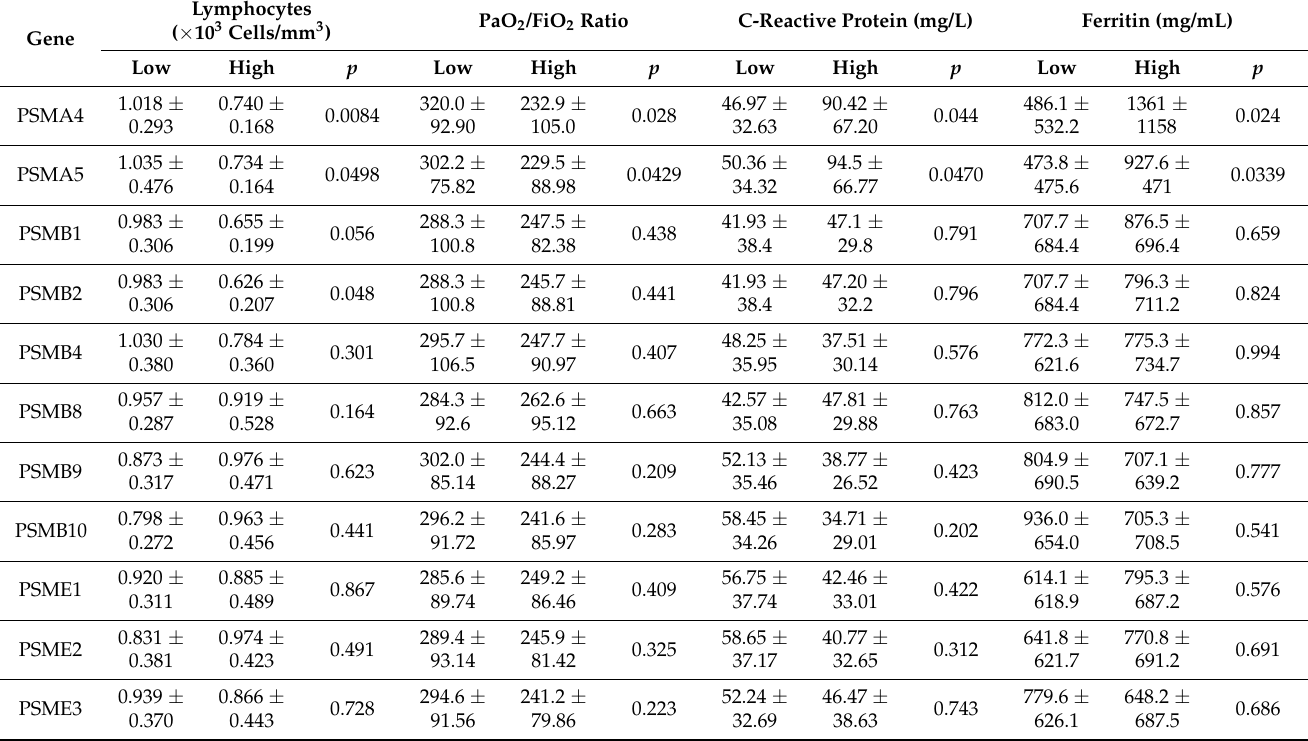
Table 2. Clinical parameters of COVID-19 patients grouped by proteasome subunits